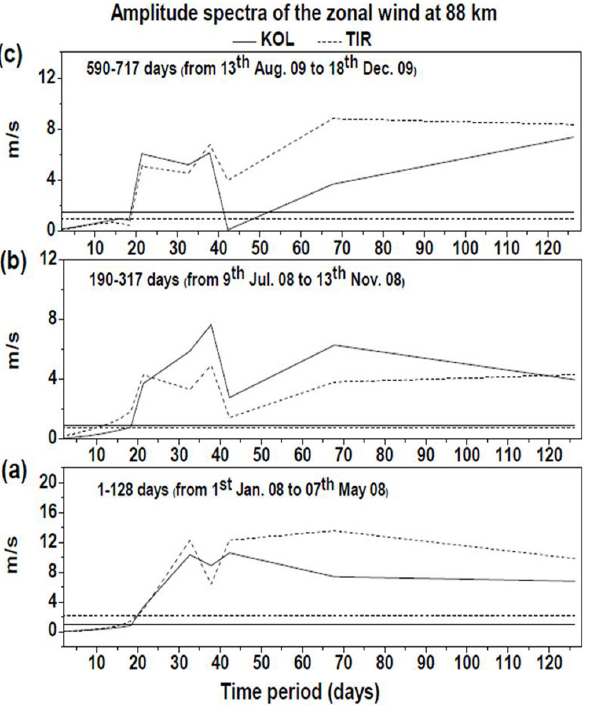
Fig. 2. Amplitude spectra of the daily zonal winds at 88km over two sites Kolhapur (KOL) and Tirunelveli (TIR) for the three time intervals (a) 1–128 days, (b) 190–317 days and (c) 590–717 days. The horizontal lines represent the 95% confidence levels.